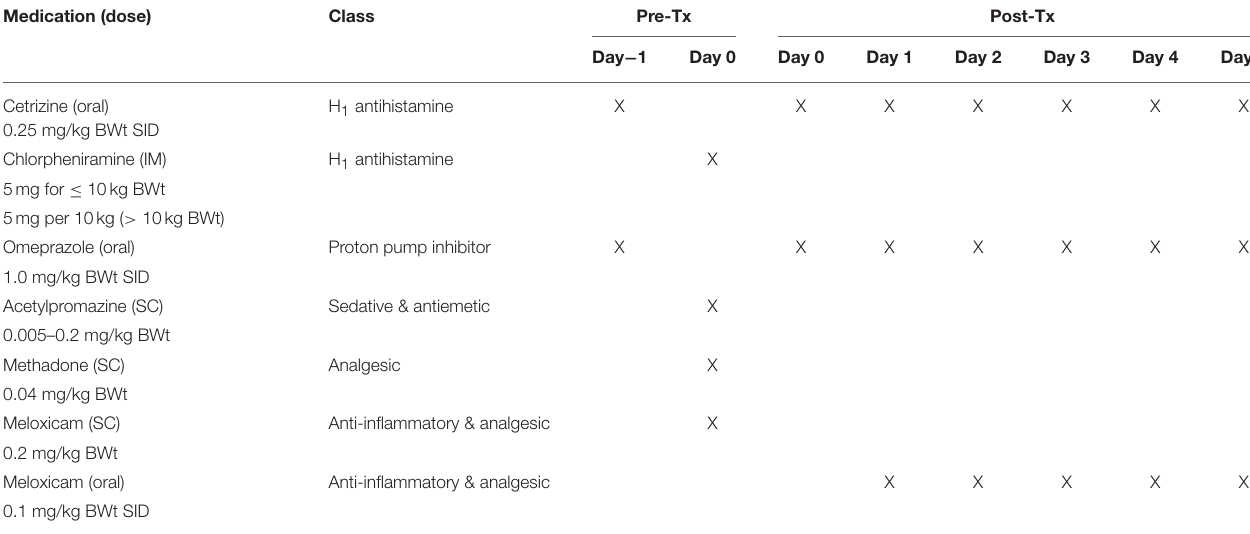
TABLE 3 | Mandatory prophylactic and supportive